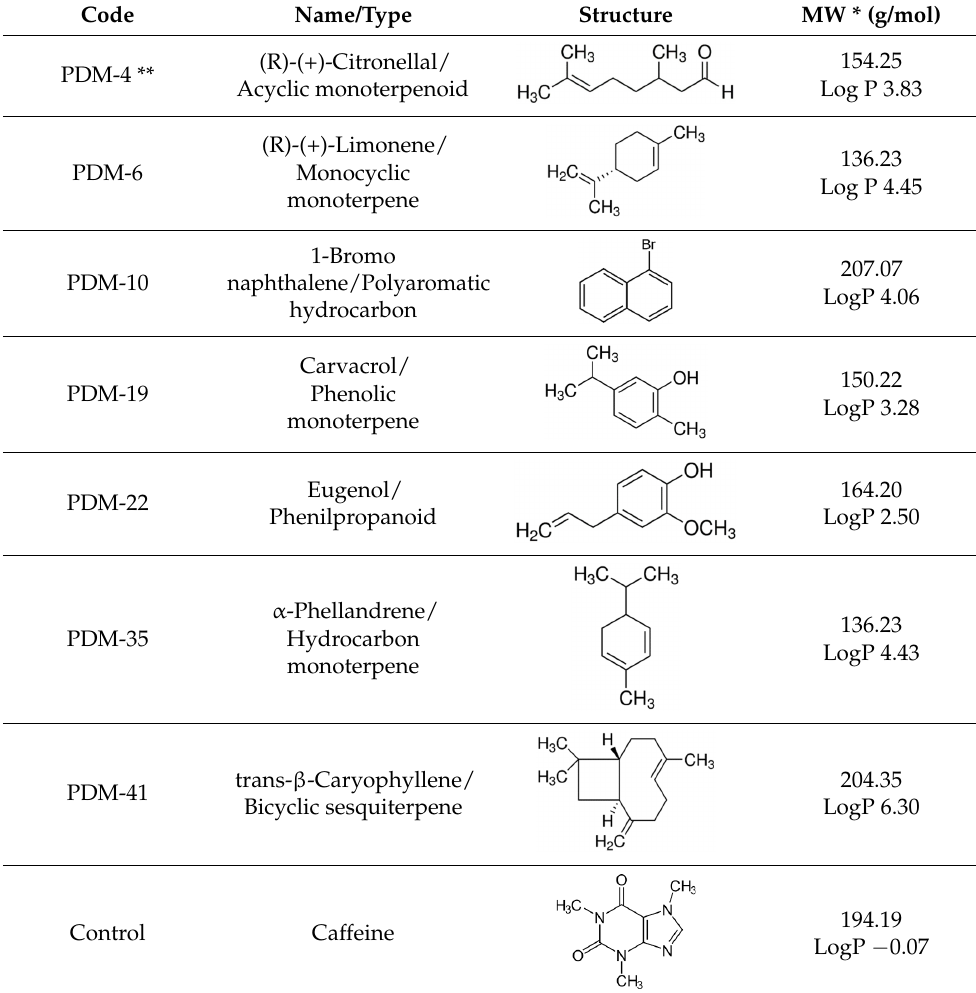
Table 4. Plant-derived metabolites (PDM) tested.